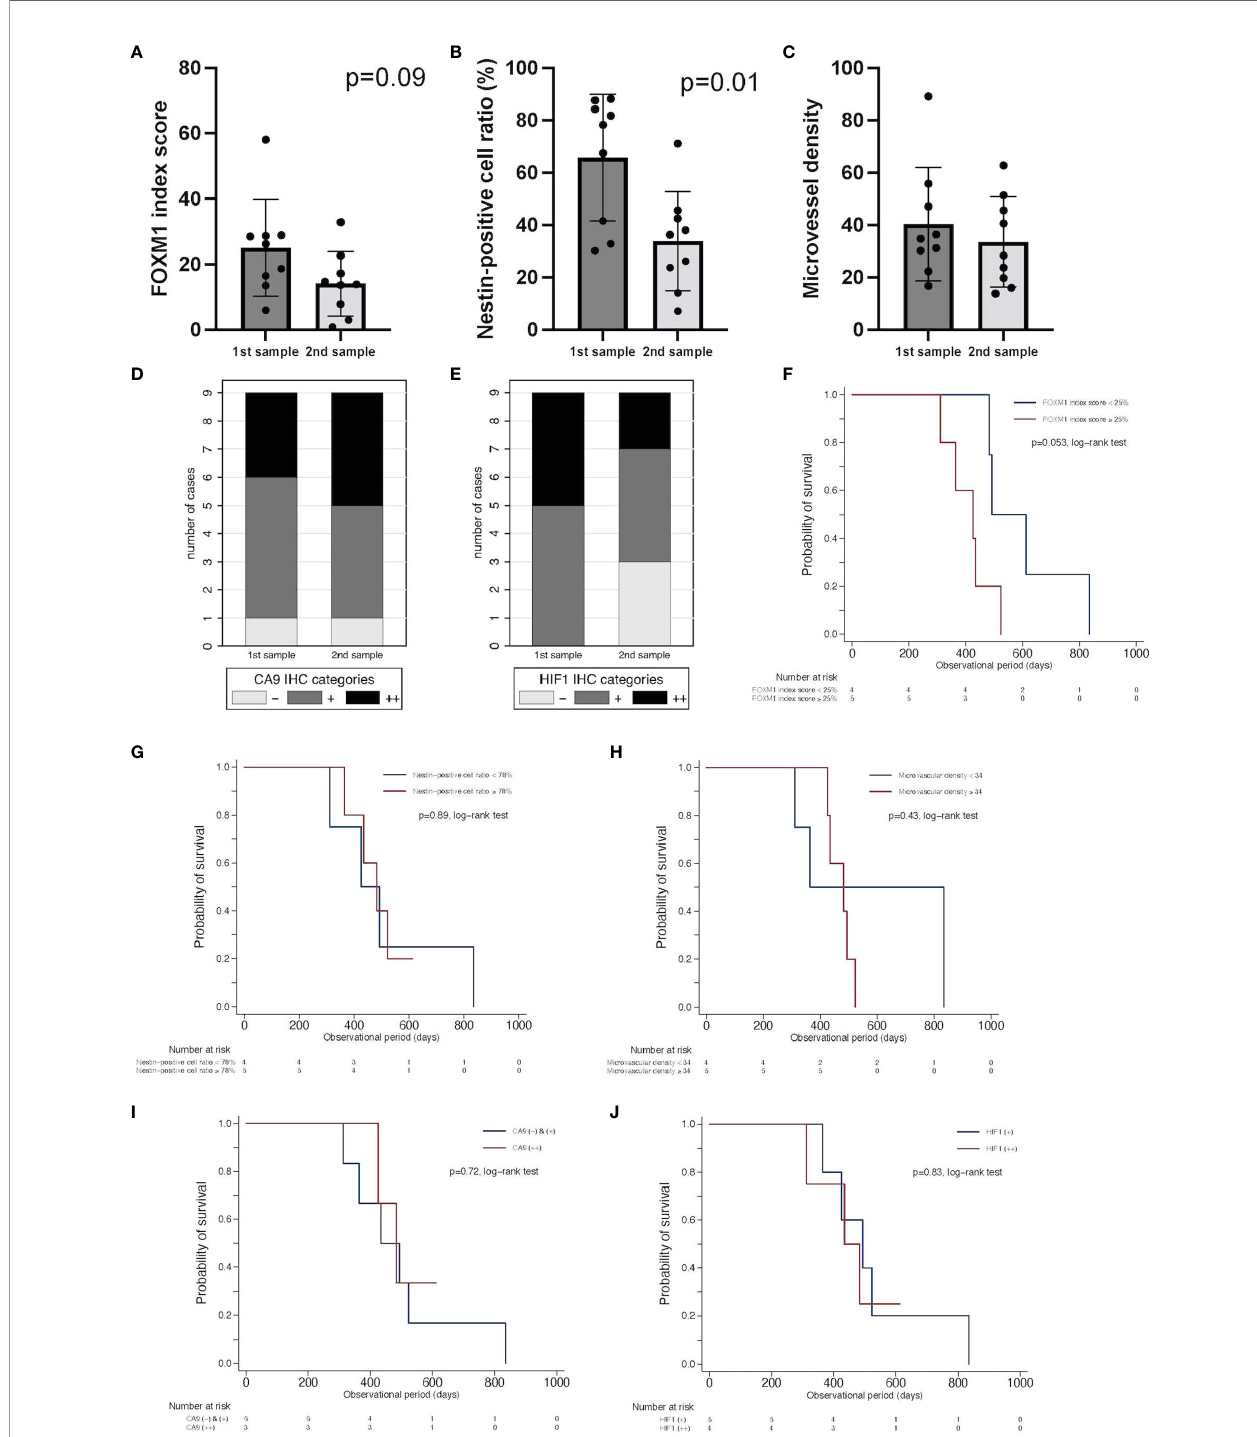
FIGURE 3 | Comparison of expression of FOXM1, tumor vascularity, and tumor oxygenation between initial tumors after neoBev and recurrent tumors after neoBev. FOXM1 (A) , nestin (B) , MVD (C) , CA9 (D) , and HIF-1 a expression (E) . Error bar; standard deviation. Kaplan – Meier survival curves showing overall survival strati fi ed by labeling index of FOXM1 expression (p = 0.053, log-rank test) (F) , labeling index of nestin expression (p = 0.89, log-rank test) (G) , microvascular density (p = 0.43, log-rank test) (H) , qualitative reaction of CA9 expression (p = 0.72, log-rank test) (I) , and qualitative reaction of HIF-1 a expression (p = 0.83, log-rank test) (J) . CA9, carbonic anhydrase 9; FOXM1, Forkhead box M1; HIF-1 a , hypoxia inducible factor-1 alpha; MVD, microvessel density; neoBev, neoadjuvant